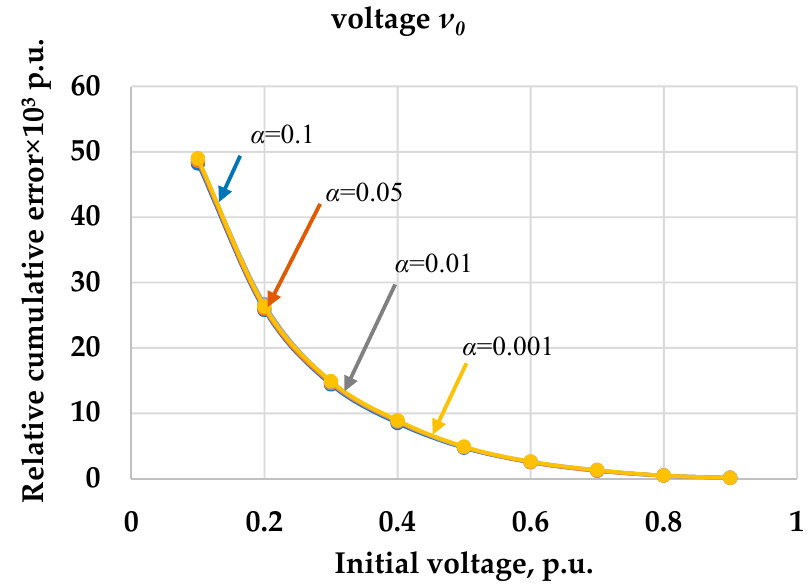
Figure 7. Weighted average quadratic error of an approximation procedure versus initial voltage and for different coefficient α .